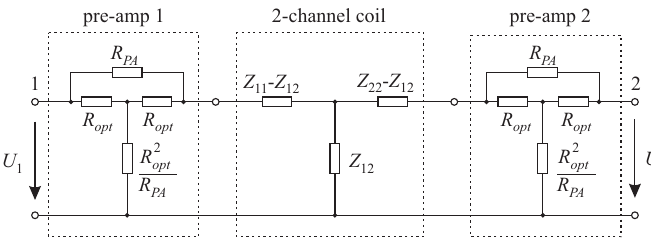
Figure 5. Noise coupling mechanism of pre-amplifier noise model of a two-channel